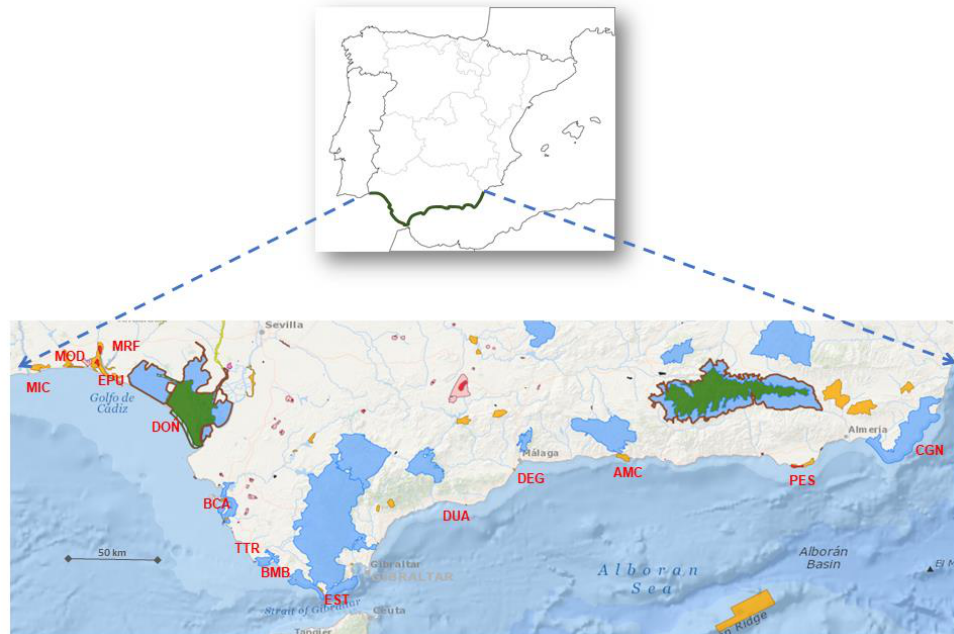
Figure 8. Location and biogeographical location of the Protected Areas studied on the Andalusian coast (Spain). AMC, Acantilados de Maro-Cerro Gordo; BCA, Bahía de Cádiz; BMB, La Breña y Marismas del Barbate; CGN, Cabo de Gata-Níjar; DEG, Desembocadura del Guadalhorce; DOÑ, Doñana; DUA, Dunas de Artola; EPU, Enebrales de punta Umbría; EST, Estrecho; MIC, Marismas de Isla Cristina; MOD, Marismas del Odiel; MRF, Marismas del Río Piedras y Flecha del Rompido; PES, Punta Entinas-Sabinar; TTR, Tómbolo de Trafalgar.